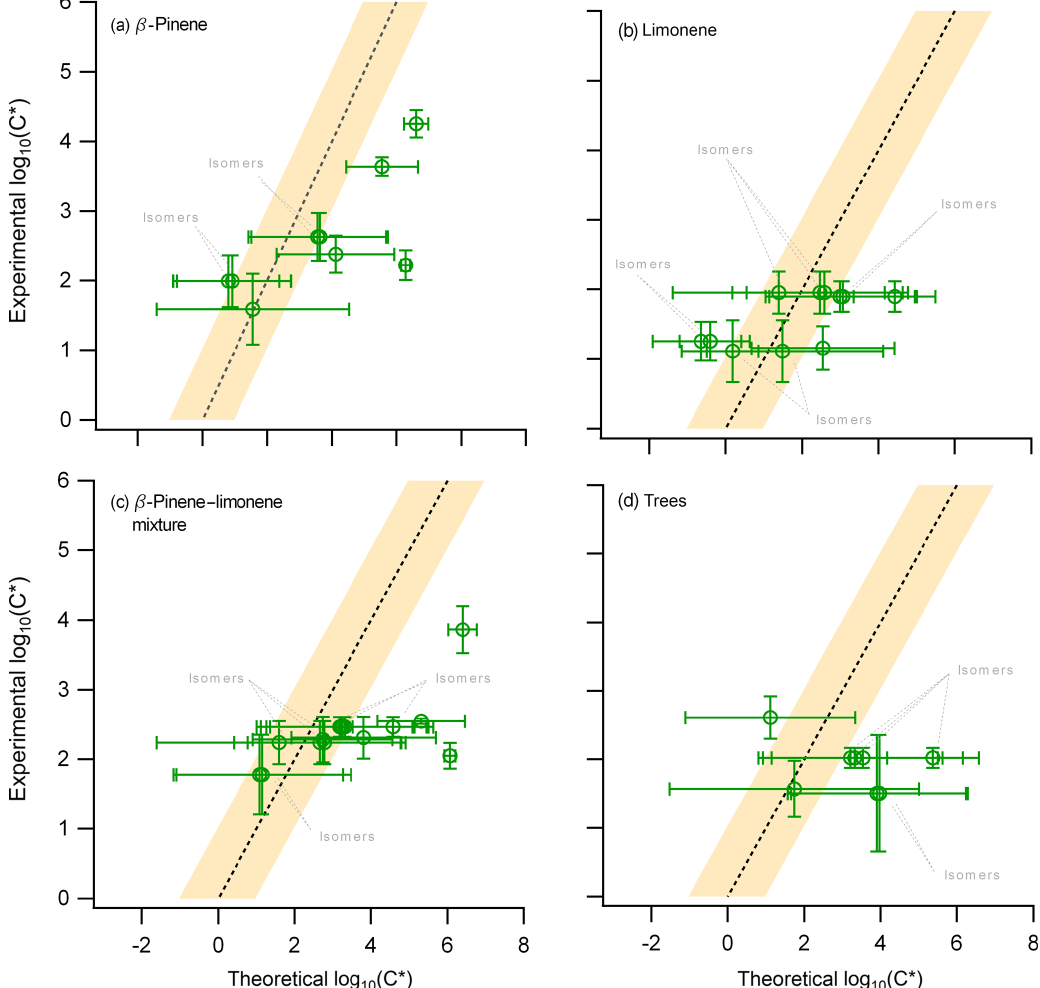
Figure 5. The experimental average saturation concentration obtained from all PTR-based techniques ( y axis) compared to the theoretical calculation of the saturation concentration ( x axis) for the (i) β -pinene, (ii) limonene, (iii) mixture of β -pinene and limonene, and (iv) the real tree emissions experiments. Error bars on the y axis indicate the ± 1 σ error of the average based on the experimental results from ACM, TD, and CHARON. The error bars for the x axis act as indicators of the minimum and maximum range of nine different theoretical approaches, with the position of the marker indicating the average of these minimum and maximum